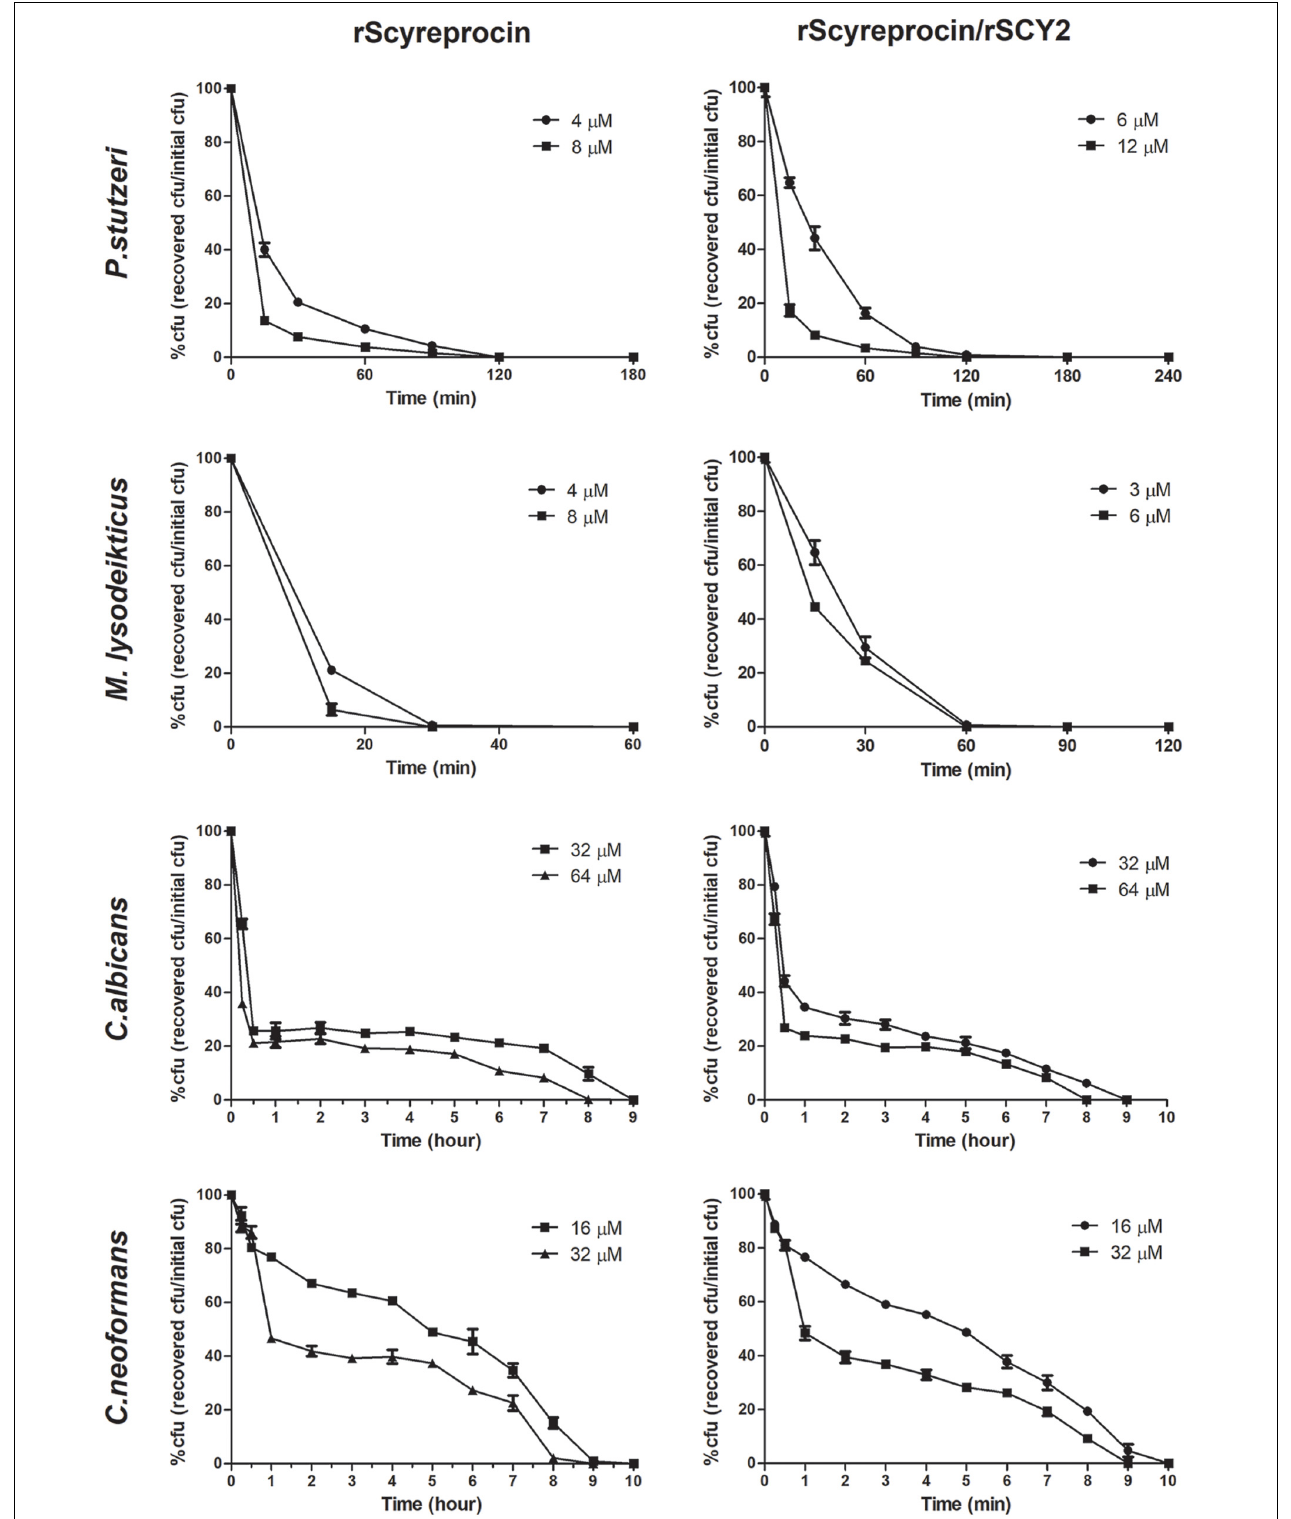
FIGURE 2 | Time-killing curves of Pseudomonas stutzeri , Micrococcus lysoleikticus , Candida albicans , and Cryptococcus neoformans treated with rScyreprocin and rScyreprocin/rSCY2. The percentage of CFU is defined relative to the CFU obtained in the control (100% CFU at 0 min). Data represent means ± SEMs of three independent determinations ( n =